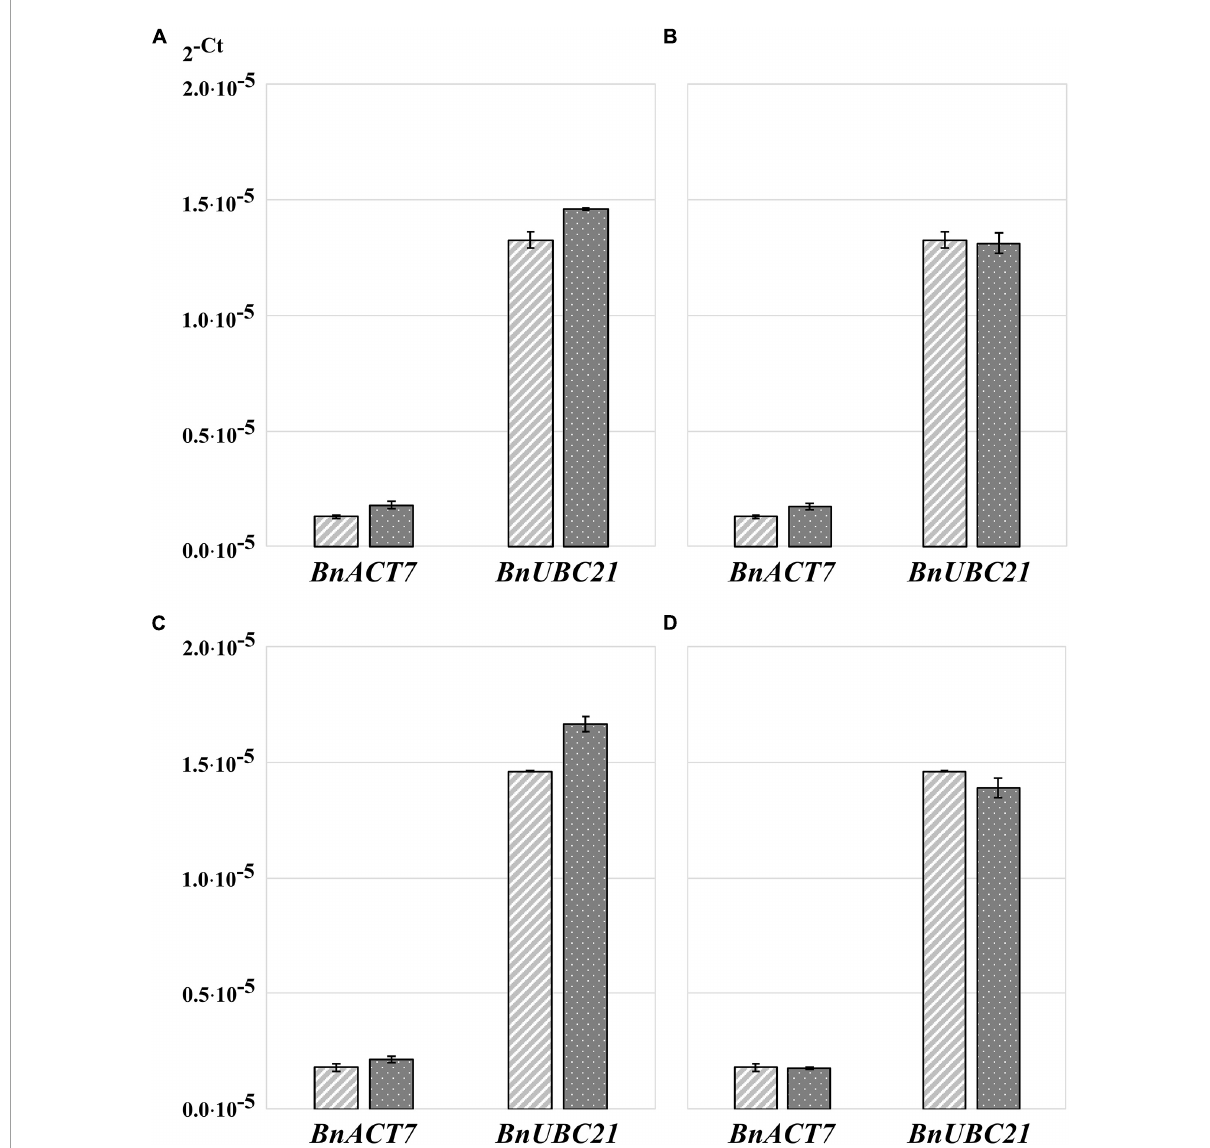
FIGURE2 Transformed cycle-threshold (2 - ct ) values of ACT7 and UBC21 transcripts in flower buds of B. napus ( v. Palma ). (A) Influence of sample homogenization without and with TRIzol TM addition on qPCR performance, light gray—samples without addition of TRIzol TM before homogenization, dark gray—samples with TRIzol addition. (B) Influence of RNA-isolation method on qPCR performance, light gray—samples isolated with TRIzol TM - Reagent, dark gray—samples isolated with RNeasy R (cid:13) plant mini kit. (C) Influence of RNA precipitation on qPCR performance, light gray—unprecipitated RNA, dark gray—precipitated RNA. (D) Influence of additional RNA purification on qPCR performance, light gray –TRIzol TM RNA without additional purification, dark gray—additionally purified RNA using NucleoSpin R (cid:13) RNA Set for NucleoZOL after TRIzol TM isolation. Error bars: standard deviation of sample (N-1) N =